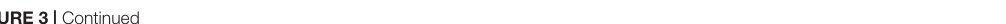
FIGURE 3 | Continued of green fluorescence of fungal hyphae relative to the root area and the respective control without bacteria. The mean value of treatment without bacteria was set as 100%. Depicted is the mean of three to four biological replicates conducted as described above. Error bars indicate the standard deviation between biological replicates. Significant differences to the control without bacteria were calculated with two-tailed Student’s T-test ( ∗ p < 0.05, ∗∗ p < 0.01). Differences to control are indicated on top of the bars. There was no significant difference between wild type strains and their respective mutants. All Pseudomonas isolates are able to reduce fungal colonization of the root surface.